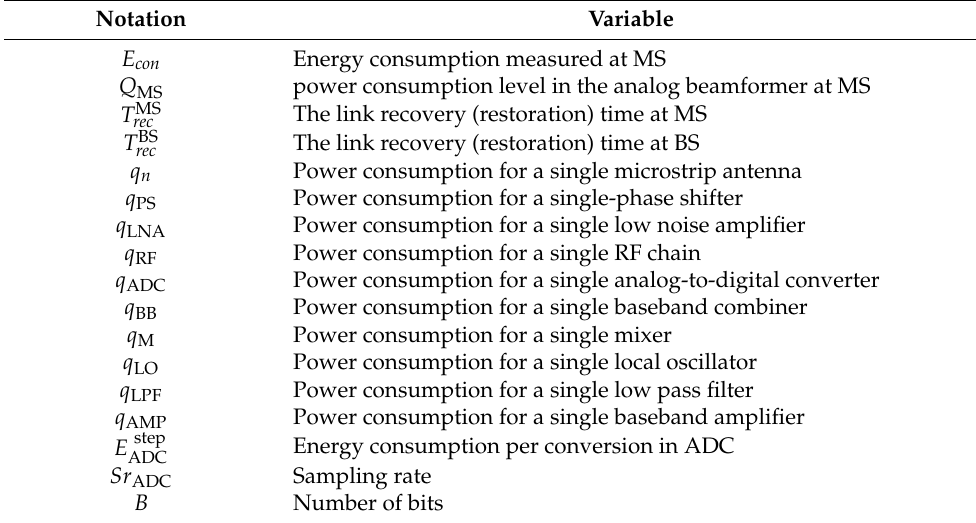
Figure 9. Energy consumption for various beamforming vectors. Table 8. List of notations for the power consumption model.